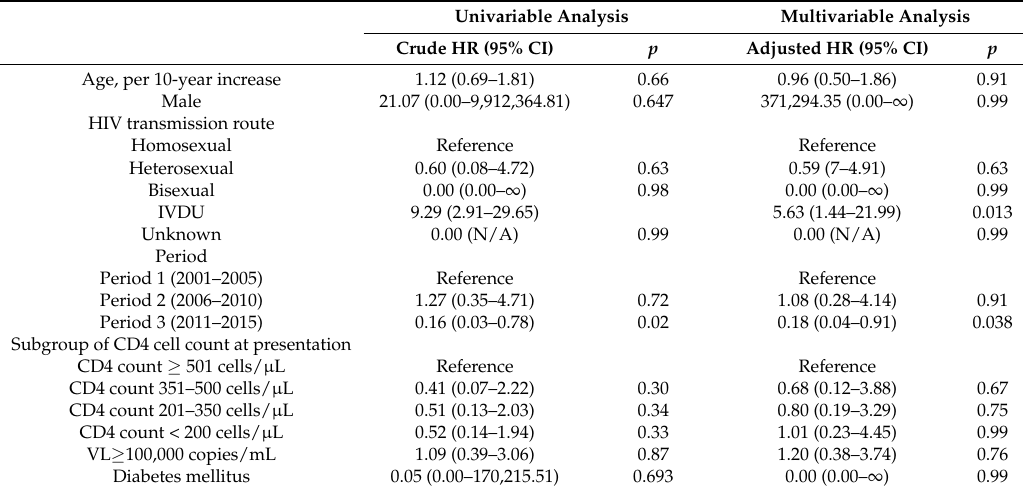
Table 4. Cox regression hazard model for factors associated with MTB disease during follow-up among patients newly diagnosed with HIV infection from 2001 to